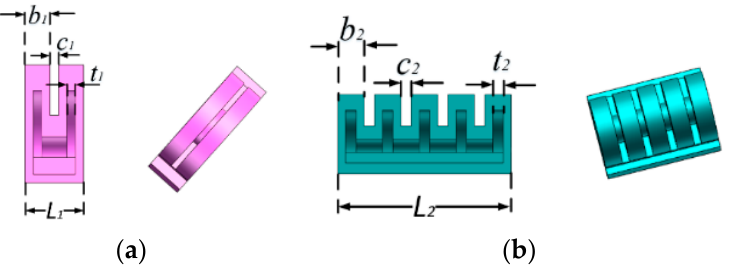
Table 1. Four-finger bending actuator structure scheme.